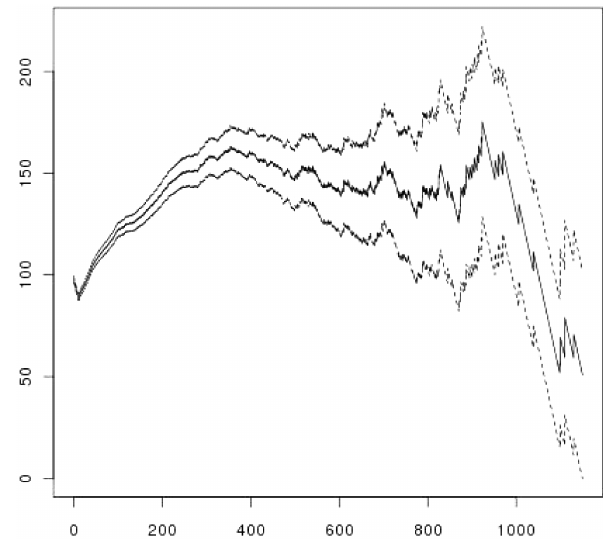
Figure 3. Mean residual life plot and associated 95% confidence interval. Horizontally: threshold, vertically: mean excess function.